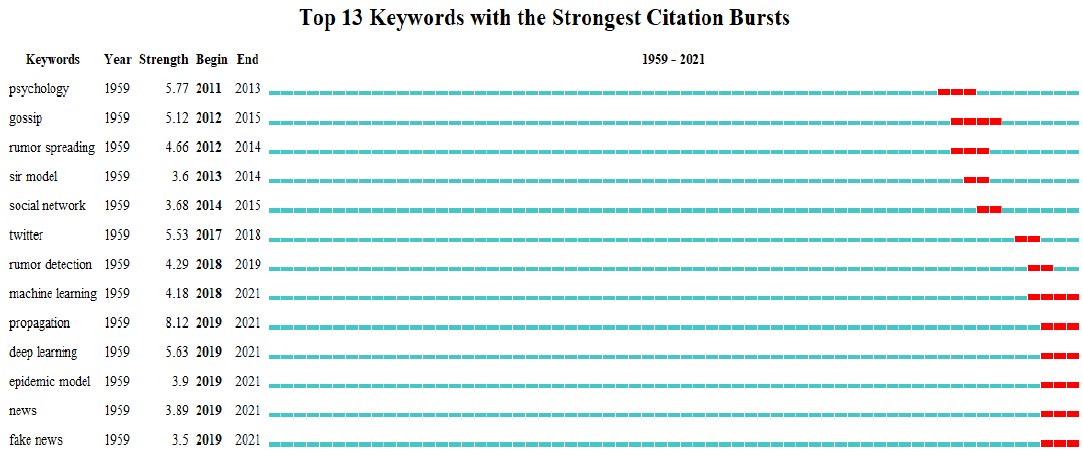
Figure 2. Top 13 keywords with the strongest citation bursts in the WOS database.